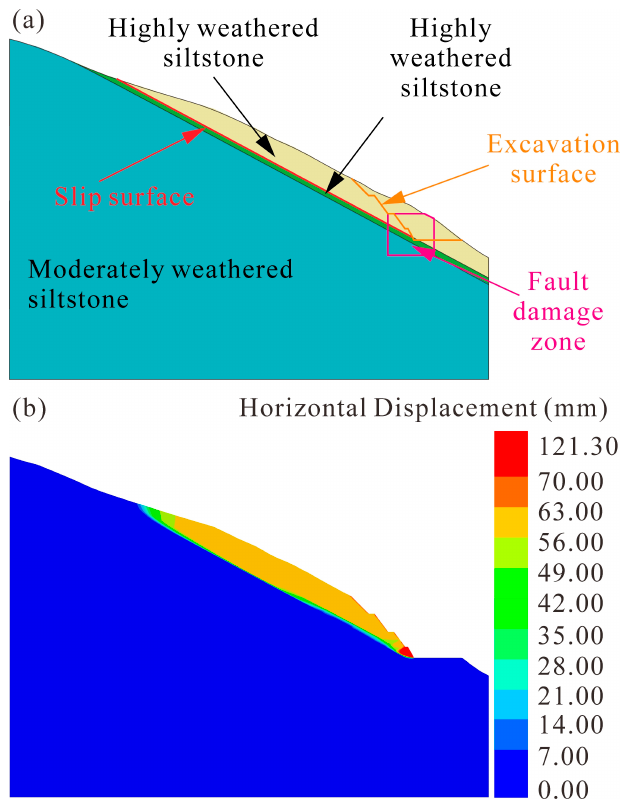
Figure 9. The influence of fault on landslide deformation. ( a ) Fault damage zone on 2-2 ′ section. ( b ) Numerical simulation of landslide deformation under the fault-influenced condition.